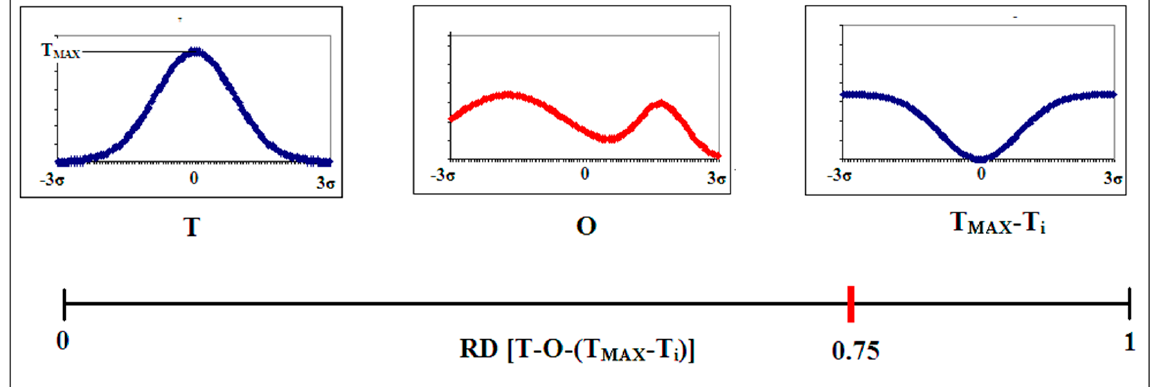
Figure 2. Introduction of a referential distribution of the inverted form of the Gaussian function. T reference distribution— centrally located; observed distribution—O; distribution in the form of T MAX -Ti—inverse to the Gaussian distribution. Below is the RD value scale with a mark at the position 0.75, which indicates the status of the O distribution.